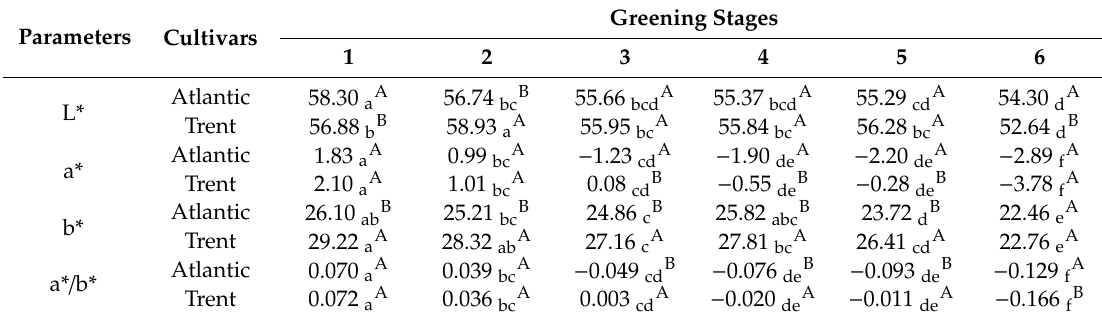
Table 1. Hunters L*, a*, b*, and a* / b* color values of ‘Atlantic’ and ‘Trent’ potato cultivars under six